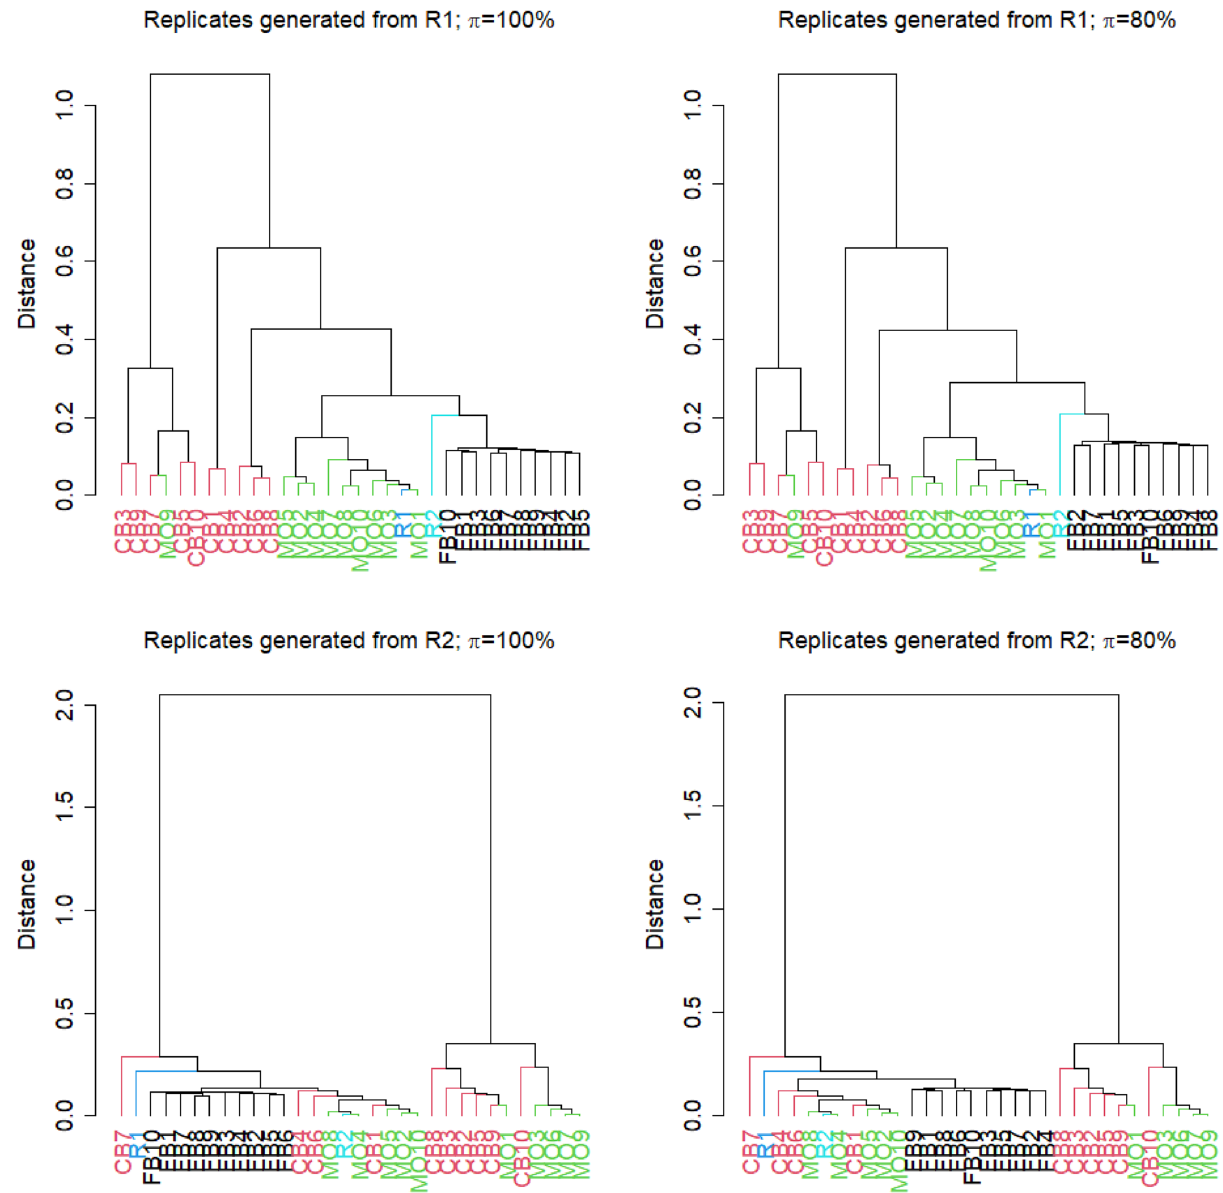
Figure 4. Cluster trees of log2 fold changes, where similarity of absolute log2 fold changes lists was specified using Spearman’s correlation coefficient ρ . R1 and R2 denote the log2 fold changes obtained from the differential expression analysis of the original two replicates. FB1 to FB10 are the log2 fold changes from the approach of generating technical replicates by boostrapping reads from FASTQ-files. CB1 to CB10 denote the results after column boostrap and MO1 to MO10 denote the results obtained by the mixing observation approach. Cluster trees were generated either when artificial replicates were generated from R1 (top) or from R2 (bottom). Furthermore, FB replicates were either sampled with π = 100% or π = 80% of reads from the original FASTQ-